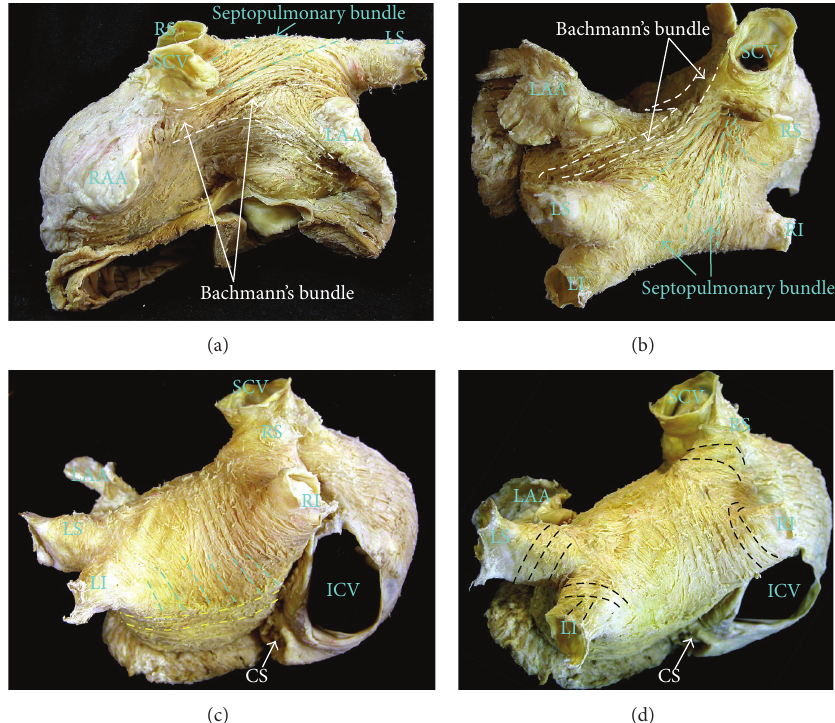
Figure 2: Serial dissections to display the atrial myoarchitecture in a normal human heart. (a) and (b) Anterior and superior views to show the Bachmann bundle crossing the anterior interatrial groove and branching toward the left atrial appendage and note also the longitudinal fibers of the septopulmonary bundle, which arises from the interatrial groove underneath Bachmann’s bundle, fanning out to line the pulmonary veinsandtopasslongitudinallyoverthedomeandintheposteriorwalloftheleftatrium.(c)Ontheposteriorwall,theseptopulmonarybundle often crossing the circumferential myocytes coming from the lateral wall which show an abrupt change of fiber orientation in the posterior wall of the left atrium. (d) Note the highly variable anatomic orientation of the myocardial fibers making up the sleeves. The myocytes sleeves are mainly composed of circularly orientated bundles; oblique and longitudinally oriented fibers are also common. SCV = superior cava vein, ICV = inferior cava vein, RAA = right atrial appendage, LAA = left atrial appendage, LI = left inferior pulmonary vein, LLR = left lateral ridge, LS = left superior pulmonary vein, RI = right inferior pulmonary vein, RS = right superior pulmonary vein, and CS = coronary